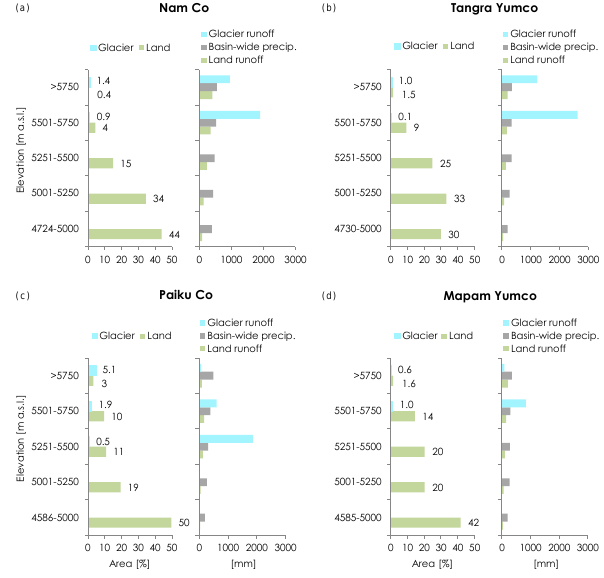
Figure 6. ( a–d , left panels) Hypsometry of glacier and non- glacierized areas based on mean elevations of respective model en- tities for the four studied basins. ( a–d , right panels) Variability of precipitation and runoff from glacier and non-glacierized areas re- lated to altitude for the four studied basins. nual AET is higher in the east ( ∼ 290 mm in the Nam Co basin) than in the west ( ∼ 170 mm in the Mapam Yumco basin) (Table 4, upper part). Impacted by the decreasing precipitation gradient spatially from east to west, the model-simulated mean annual land runoff in the Nam Co basin ( ∼ 130 mm) is estimated to be more than twice that in the Mapam Yumco basin ( ∼ 60 mm) during the study period (Table 4, upper part). The combina- tion of various influencing variables such as local climate, topography, land cover, soil and hydro-geological properties results in a spatially heterogeneous pattern of runoff gener- ation within the catchments. Figure 6 illustrates the altitu- dinal dependence of the mean annual basin-wide precipita- tion total and runoff from glaciers and non-glacierized land areas, as computed by the J2000g model. The area–altitude relation (hypsometry) for glacier and non-glacierized areas is based on mean elevations of the respective model en- tities. Larger precipitation amounts in the high mountain- ous and hilly headwater areas result in higher land runoff estimates compared to lower elevation areas (Fig. 6). In- deed, the increase in land runoff with altitude is higher than the elevation-dependent increase in precipitation. The non- glacierized high-elevation areas characterized by sparse veg- etation, poorly developed soils, steep topography and lower air temperatures indicate smaller soil-water contents and lower AET rates compared to lower elevation bands, result- ing in higher runoff